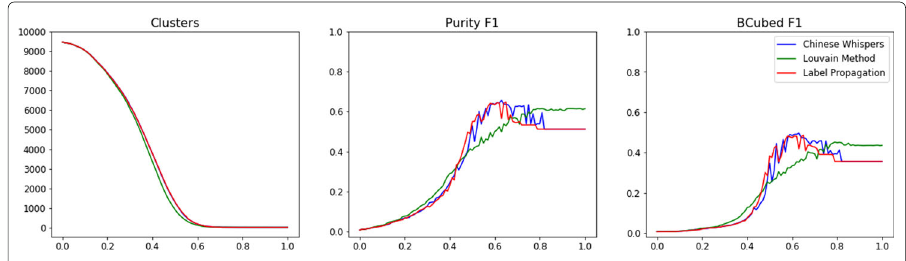
Fig. 10 Semantic role induction results on the test data. The horizontal axes refer to the neighboring threshold used to create the edges